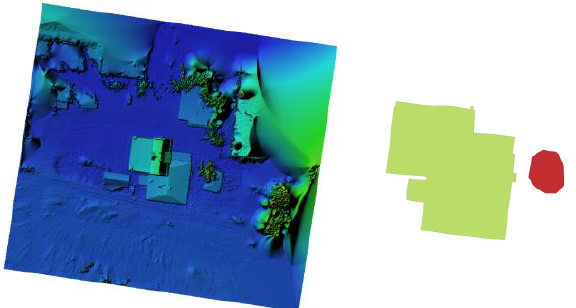
Figure 3. A DSM 𝐻 (left) and a polygon 𝐵 representing the building contour (green) are used as main data input for mission planning. Optionally, polygons 𝑁 defining no-trespass areas can be used. Here, a single polygon (red) is used to mask an imprecisely reconstructed tree close to the building.